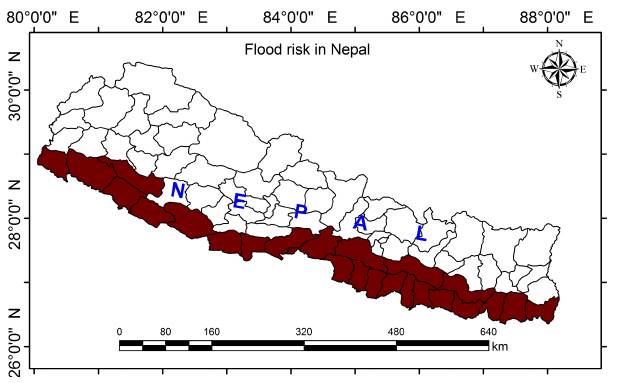
Figure 3. Districts in Nepal, map numbers indicate (1) Taple- jung, (2) Panchthar, (3) Ilam, (4) Jhapa, (5) Sankhuwasabha,